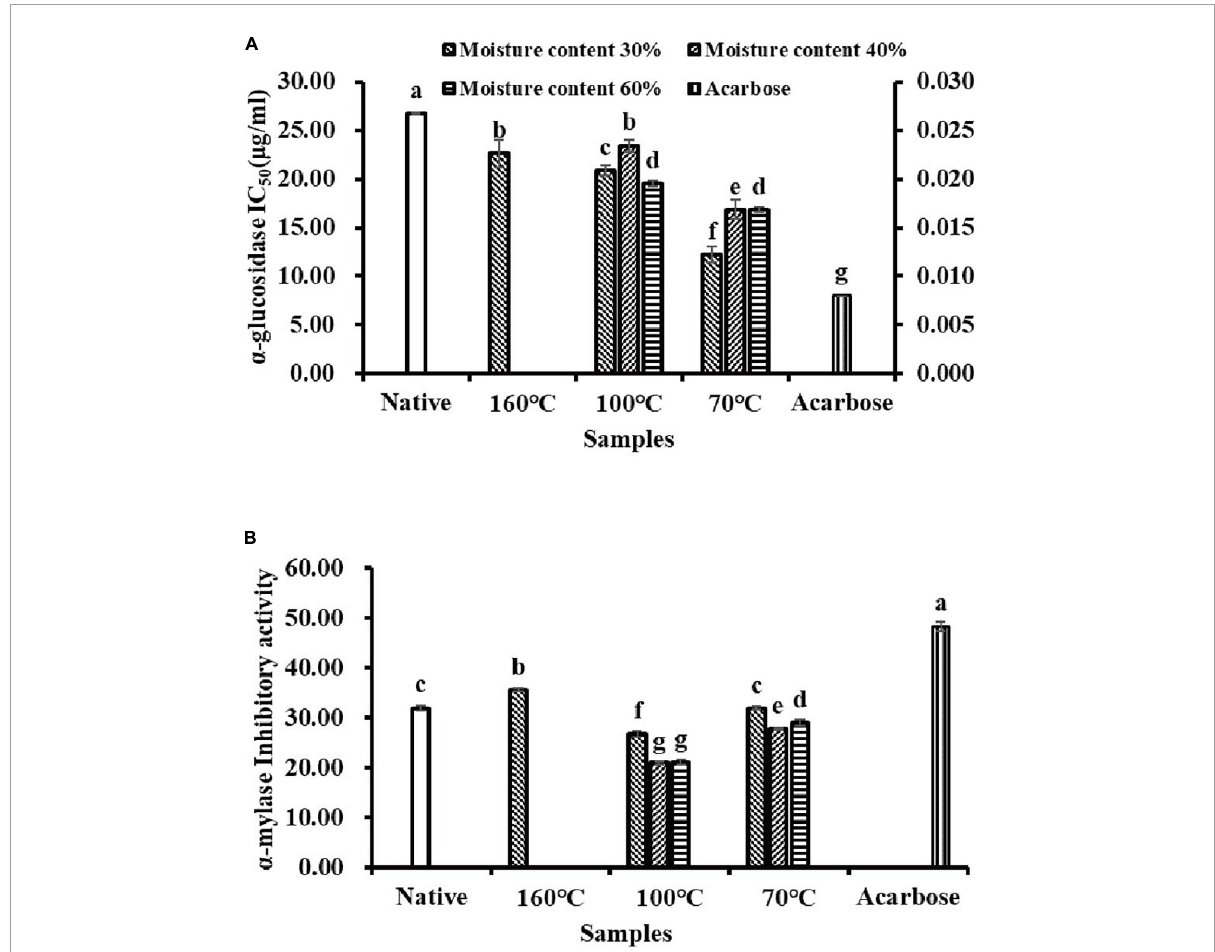
FIGURE3 The α -glucosidase (A) and α -amylase (B) inhibitory activities of flavonoids extracts isolated from native and pregelatinized Tartary buckwheat